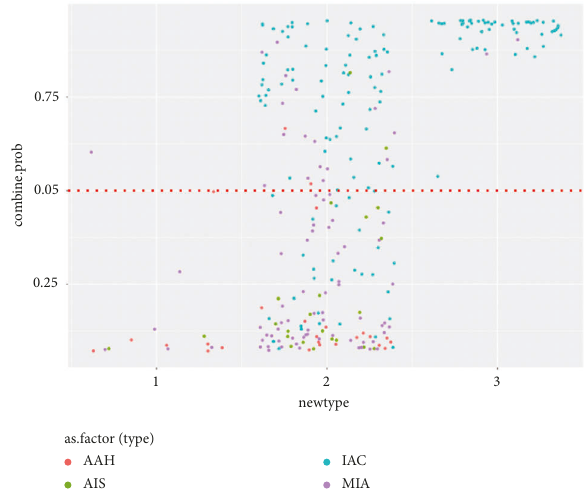
Figure 8: Jitter plot of nodule classifications with their model predictive values. It illustrates that using a model predictive value of 0.5 (shown with a red dot) as the cut-off, a correct reclassification with respect to histological invasiveness would be identified, es- pecially for type 2 nodules.